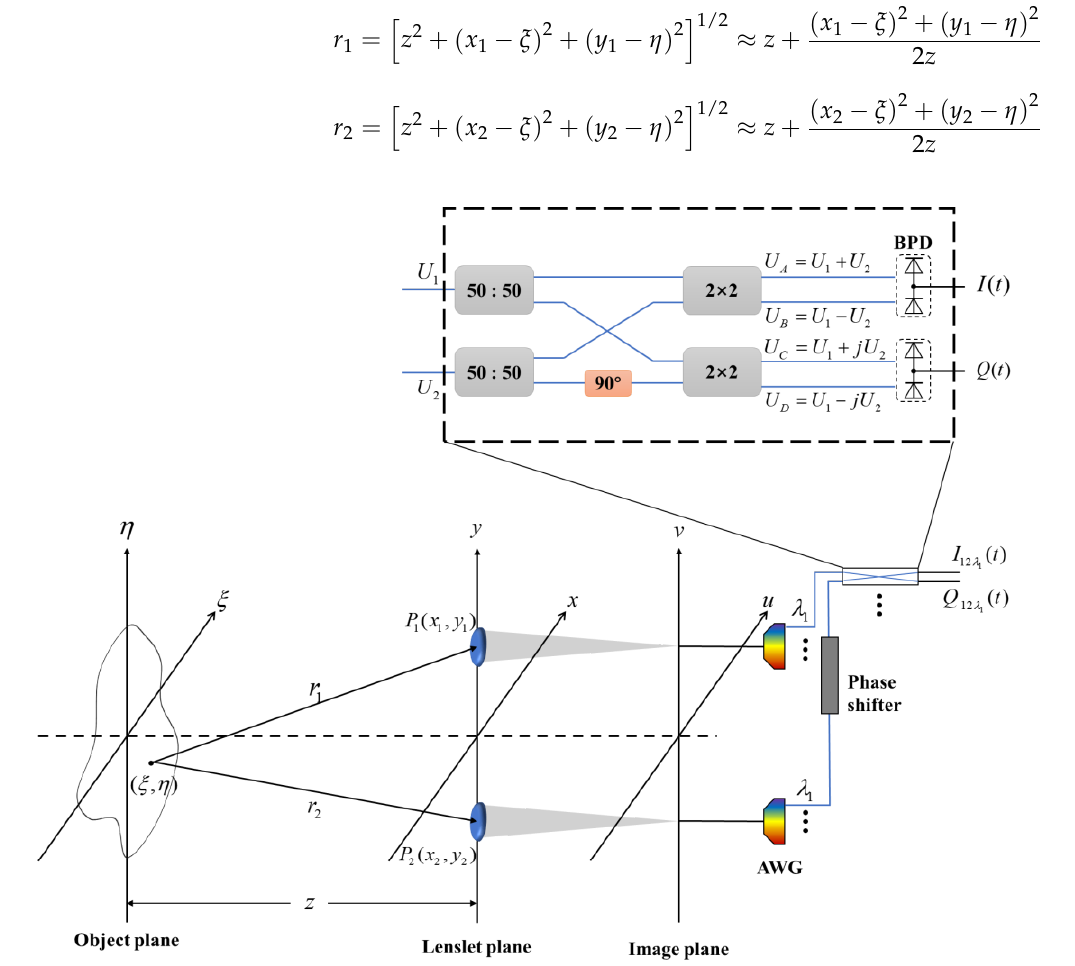
Figure 2. Diagram of the light propagation in the segmented planar imaging system.